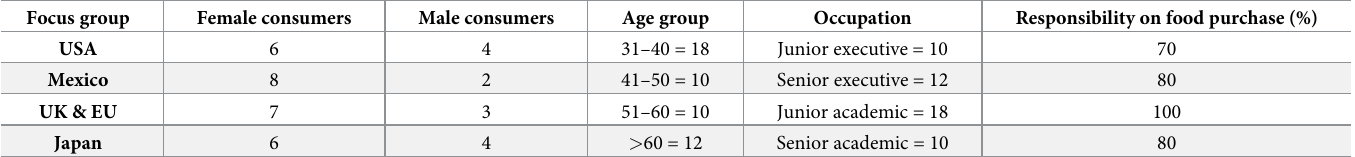
Table 1. Consumer profile of the focus group discussions.